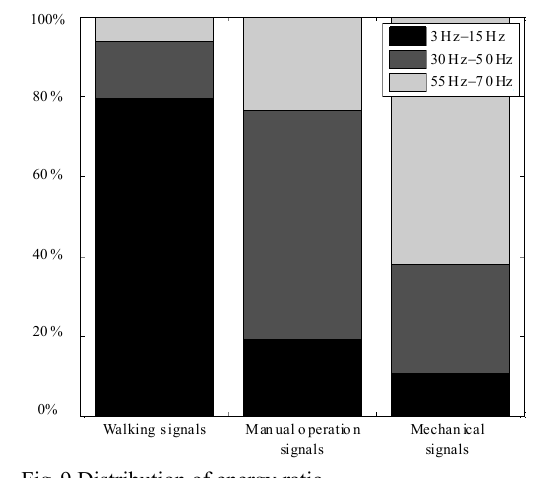
Fig. 9 Distribution of energy